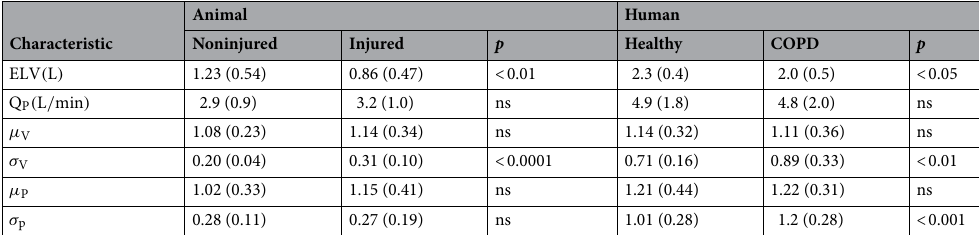
Table 1. Results of the simulation-based optimisation in three datasets. Mean and standard deviation are shown. ELV : Effective lung volume; Q P : pulmonary blood flow; µ V and σ V : mean and standard deviation of the ventilation lognormal distribution; µ P and σ P : mean and standard deviation of the perfusion lognormal distribution. Student’s t test was applied with ns =